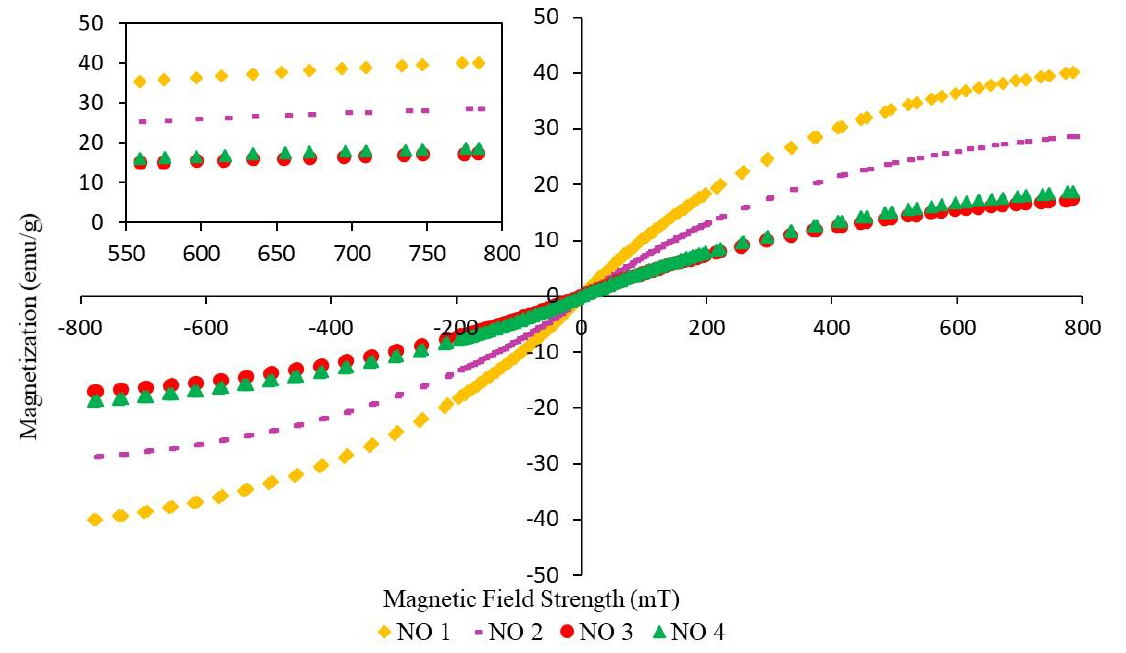
Figure 7. Magnetization curves of NR-based MREs for different ratios of NO:AO.